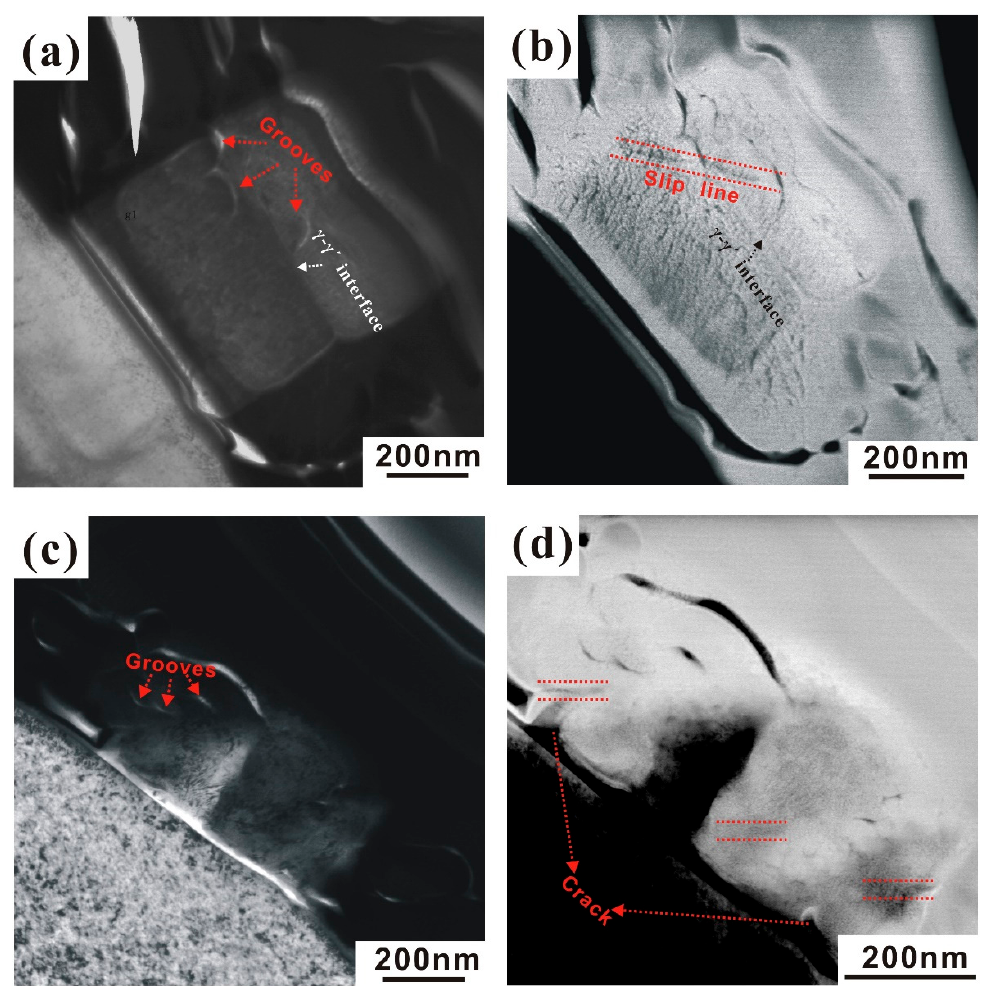
Figure 7. Crack initiation of various shaped Ni 3 Al nanocubes and formation of grooves at γ – γ ’ interfaces. ( a , b ) Aligned cube; ( c , d ) double cube. interfaces. ( a , b ) Aligned cube; ( c , d ) double